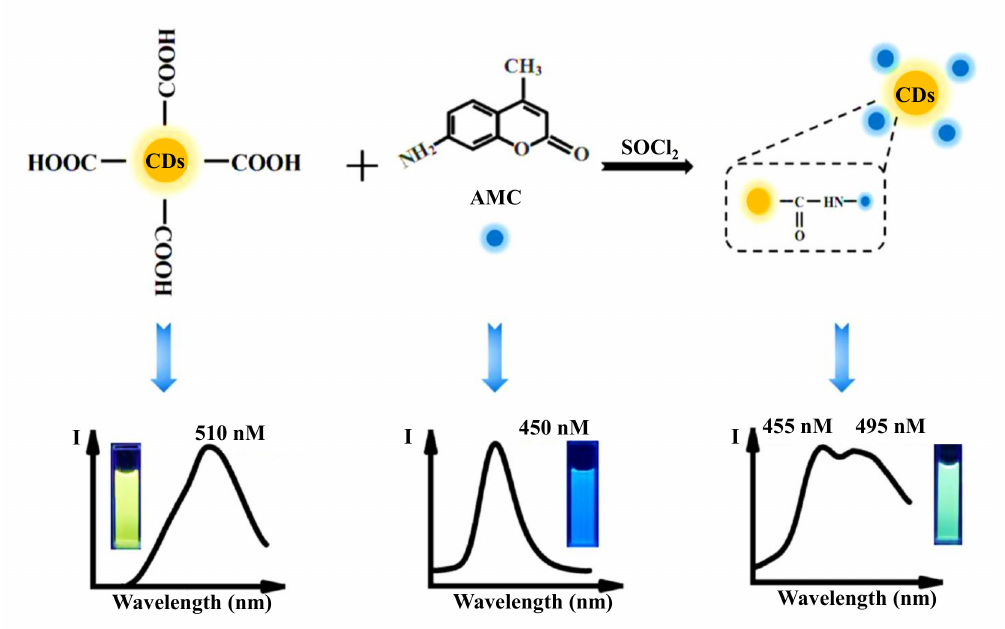
Figure 20. A graphical illustration of a dual-emission ratiometric fluorescence sensing method using 7-amino-4-methylcoumarin (AMC) and carboxylated-CDs nanohybrid. Reproduced from [265], with permission from Elsevier,